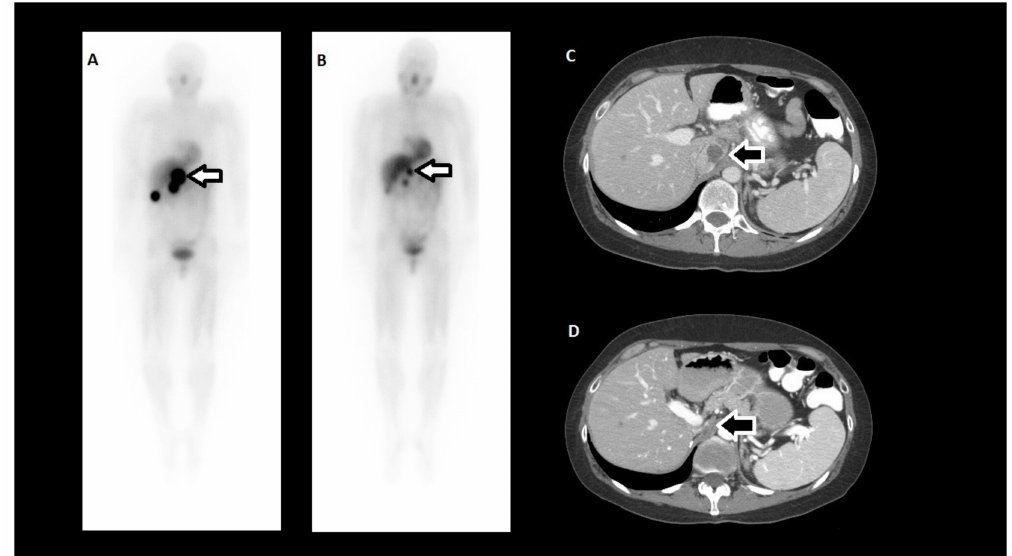
Figure 4. Clinical example of a tumor radiographic response to HSA-I-131-MIBG in a patient treated at The University of Texas MD Anderson Cancer Center. ( A ) HSA-131-MIBG scan 3 days after the first treatment; ( B ) HSA-131-MIBG scan 3 days after the second treatment; ( C ) Computed tomography prior to the first HSA-131-MIBG treatment; ( D ) Computed tomography 11 months after the second HSA-131-MIBG treatment (44% reduction in longest tumor dimension). Arrows indicate the